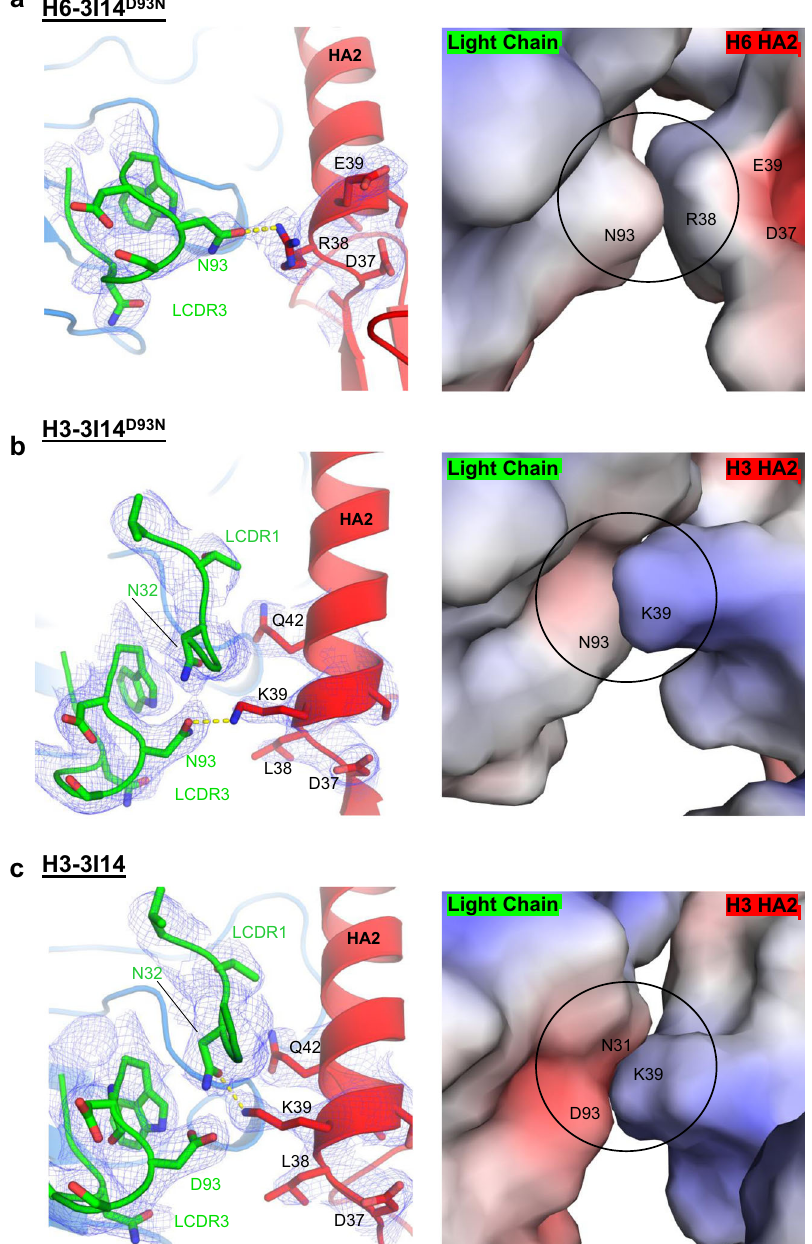
Fig. 4 3I14 and 3I14 D93N binding to H6 and H3 HAs. a H6-3I14 D93N complex; b H3-3I14 D93N complex; c H3-3I14 wild-type complex. Left panels show the LCDR3 as green cartoon and sticks, and HA shown as red cartoon and sticks. 1 σ 2 F o – F c electron densities are shown in blue. Hydrogen bonds are depicted as yellow dashed lines. Panel on the right is an electrostatic surface representation of the image from the